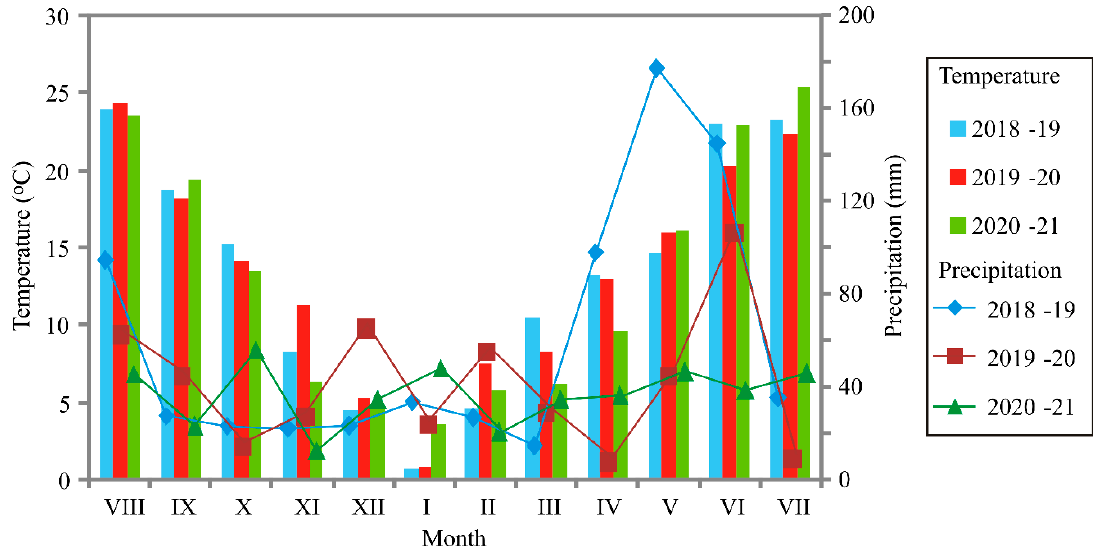
Figure 2. The weather conditions during the three successive growing seasons.